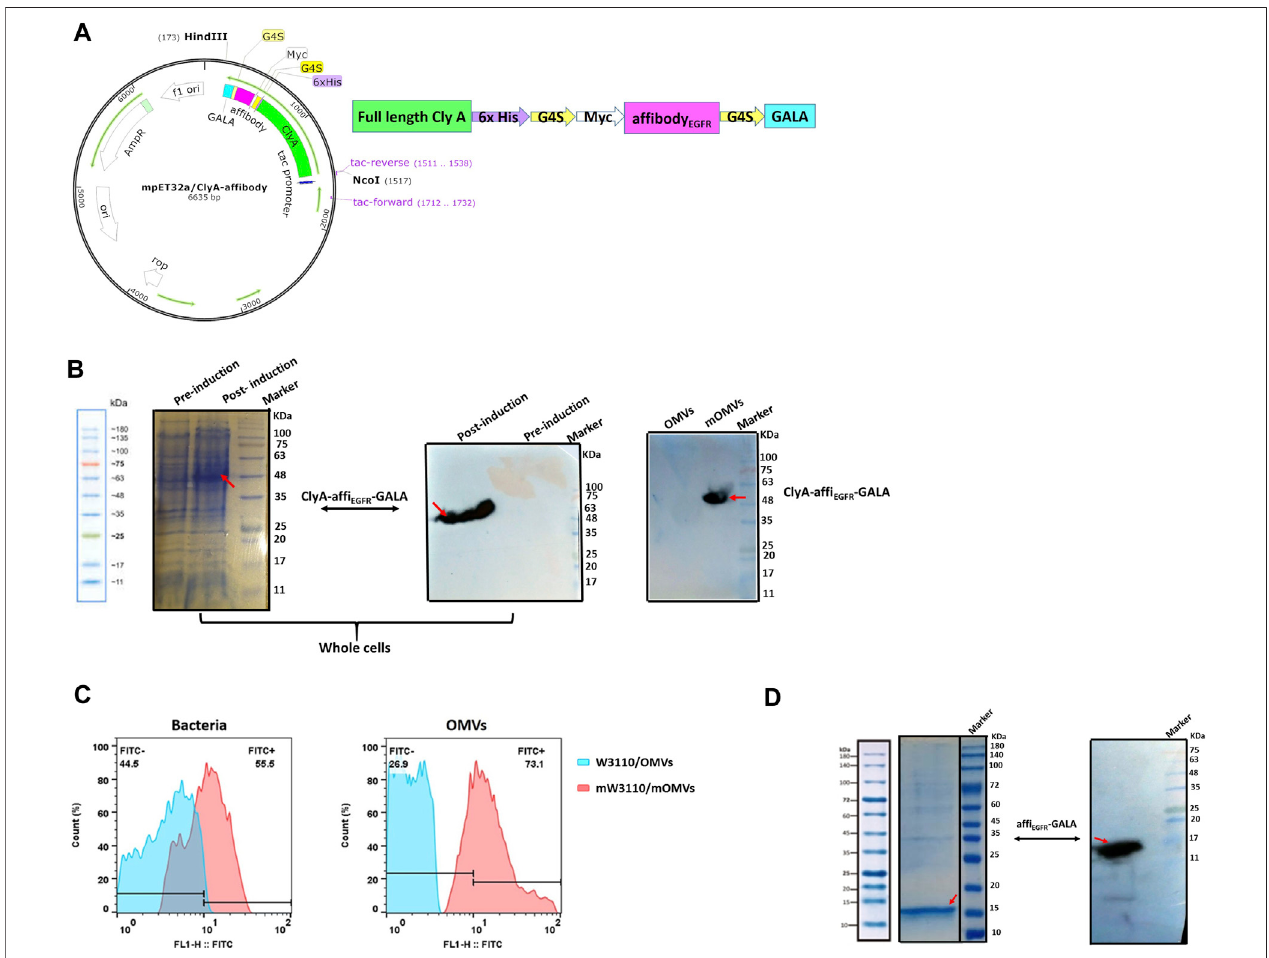
FIGURE 1 | Protein expression analysis. (A) Schematic diagram of ClyA-af fi EGFR -GALA construct. The orientation of fragments used in the construct has been shown. (B) Expression of the ClyA-af fi EGFR -GALA fusion protein was evaluated in Δ msbB/ Δ pagP W3110 using 10% SDS-PAGE and Western blotting in total bacterial proteinsamples (leftandmiddle) andtheengineeredOMVs (right) (mOMVs:modi fi edOMVs). (C) Immune fl uorescenceanalysisofthelocationofClyA-af fi EGFR -GALA. Δ msbB/ Δ pagPW3110cellsandtheirderivedOMVsweresurfacestainedusingananti-af fi bodyantibody. (D) 12%SDS-PAGE (left) andWesternblotting (right) of the puri fi ed af fi EGFR -GALA in BL21